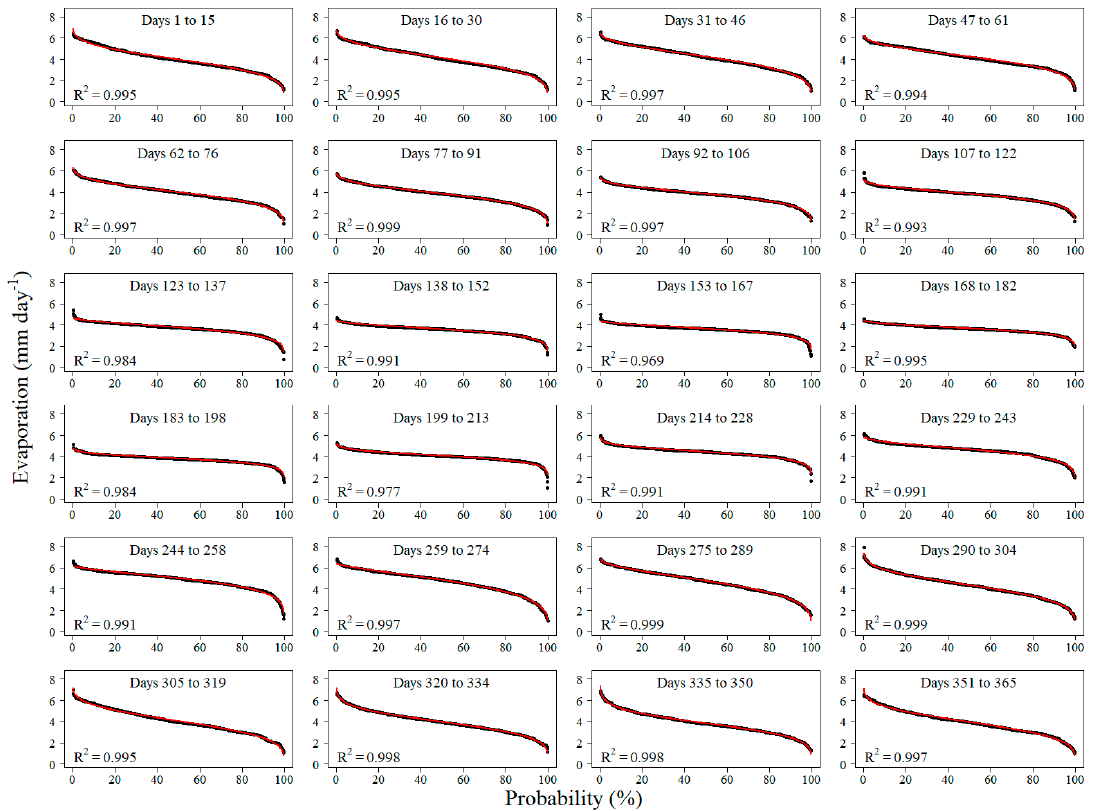
Figure 9. Daily evaporation curves built for fortnightly periods based on the historical climatic data.